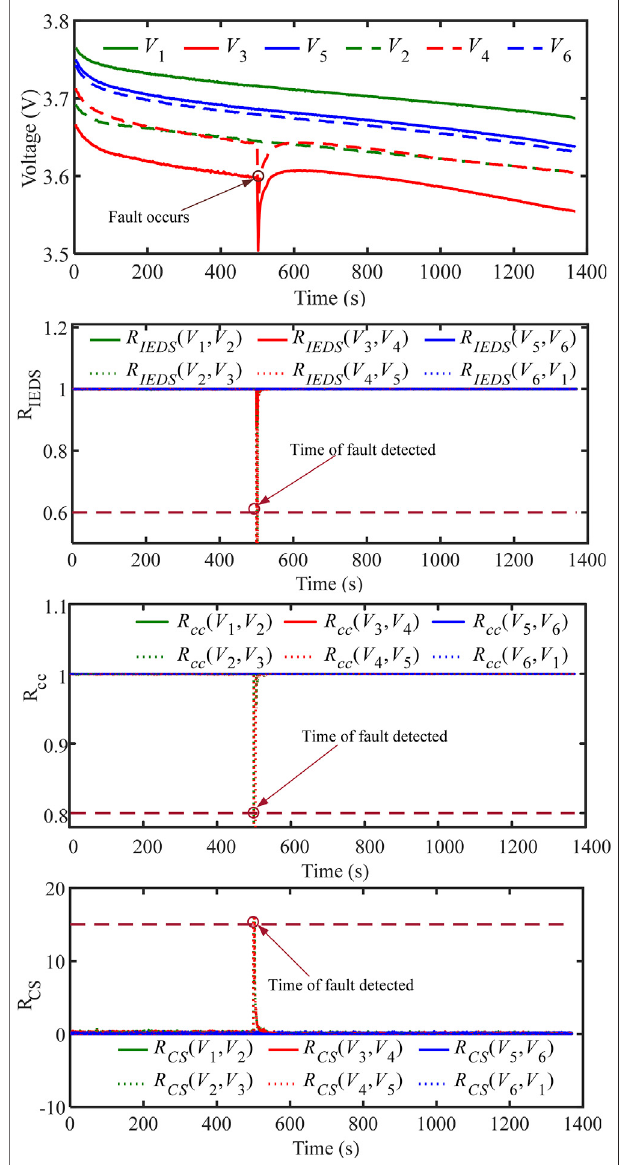
FIGURE10| ESCfaultevaluationresults.(a)Voltagecurve.Diagnosisby (b) R IEDS , (c) R cc , (d) R CS